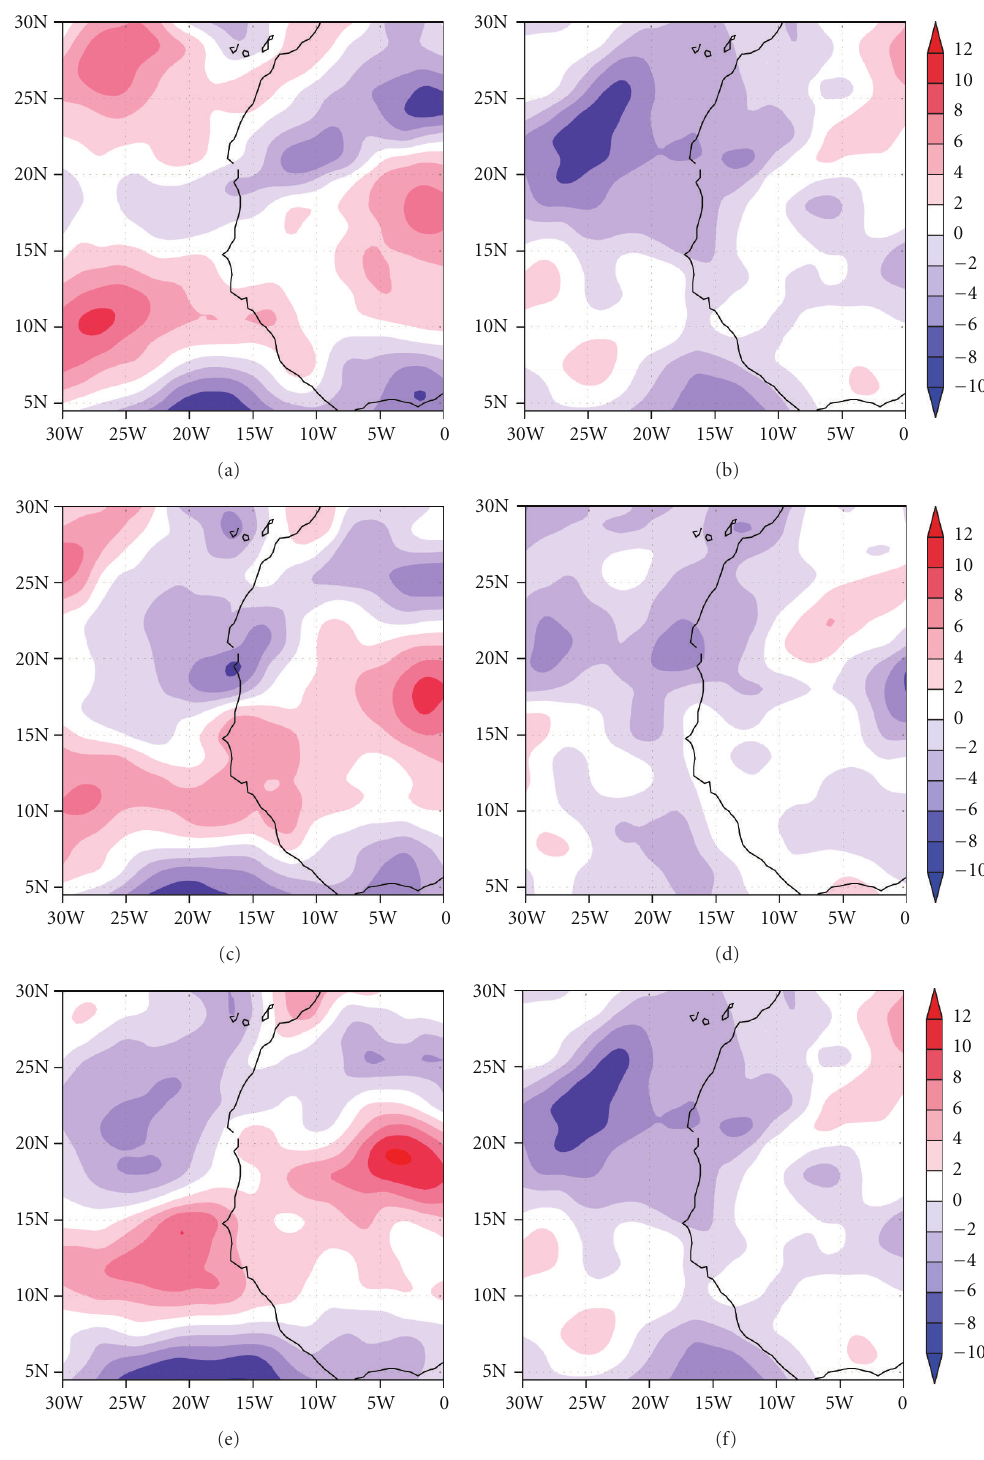
Figure 8: Mean total precipitable water (TPW) anomalies for times prior to, during, and after the MCS event for the mean TCP case (a), (c), and (e) and for the mean NTCP case (b), (d), and (f). Red values indicate positive anomalies, and blue values indicate negative anomalies. Shading contours are every 2